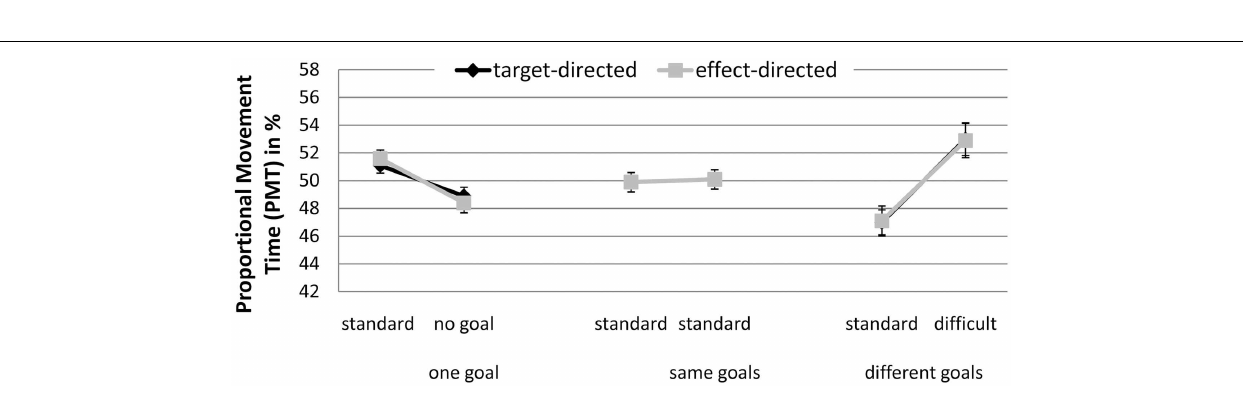
FIGURE 2 | Experiment 1: means and confidence intervals of ProportionalTime to PeakVelocity in % (PTPV).